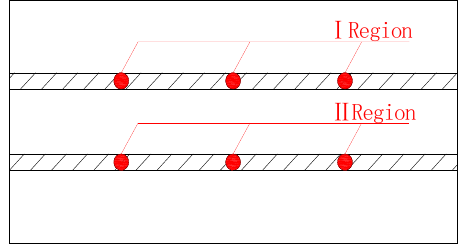
Figure 3. Position of concrete powder extracted area.